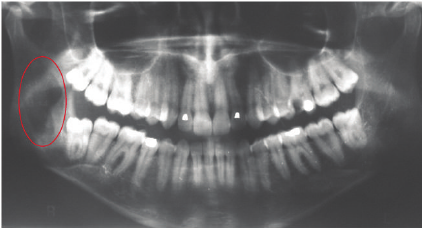
Figure 1: OPT show radiolucency in the right mandibular ramus.